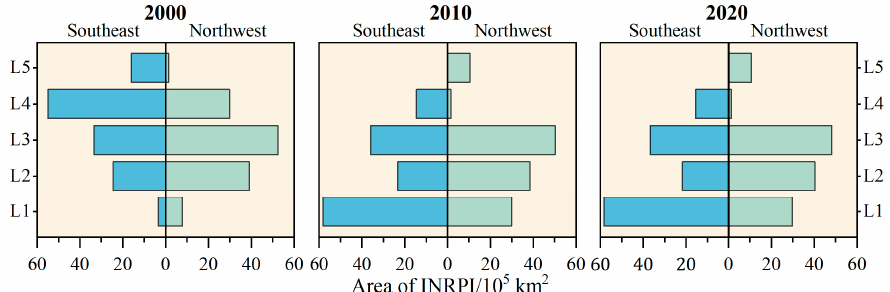
Figure 5. Difference in INRPI on both sides of the Qilian-Gyirong line (L1 is the very low potential; L2 is the low potential; L3 is the moderate potential; L4 is the high potential; and L5 is the very high